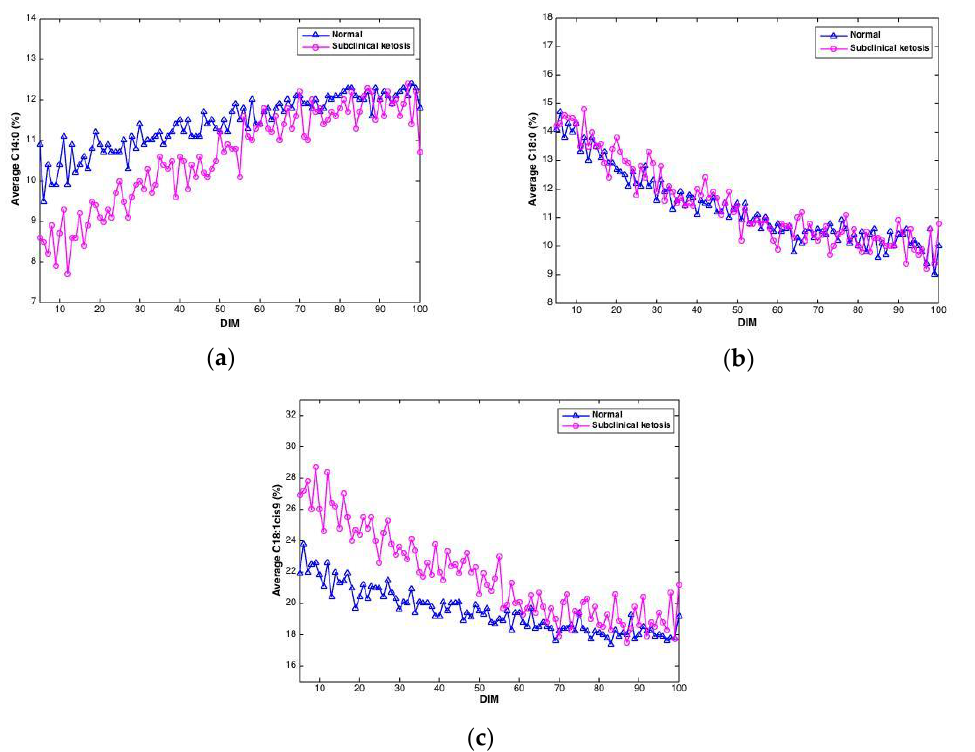
Figure 6. Average contents of C14:0 ( a ), C18:0 ( b ) and C18:1cis9 ( c ) in milk samples from cows experiencing subclinical ketosis (red) and normal cows (blue).